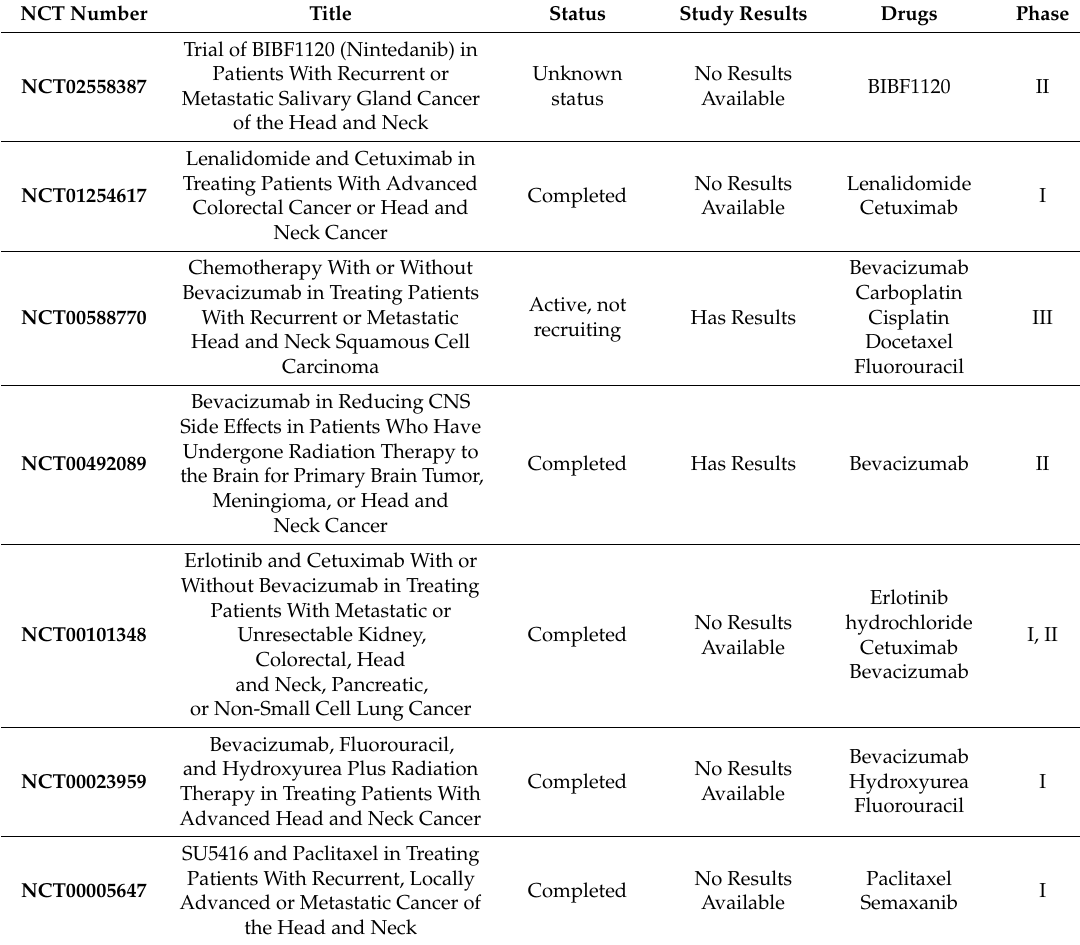
Table 3. Current clinical trials relevant to angiogenesis and salivary gland malignant